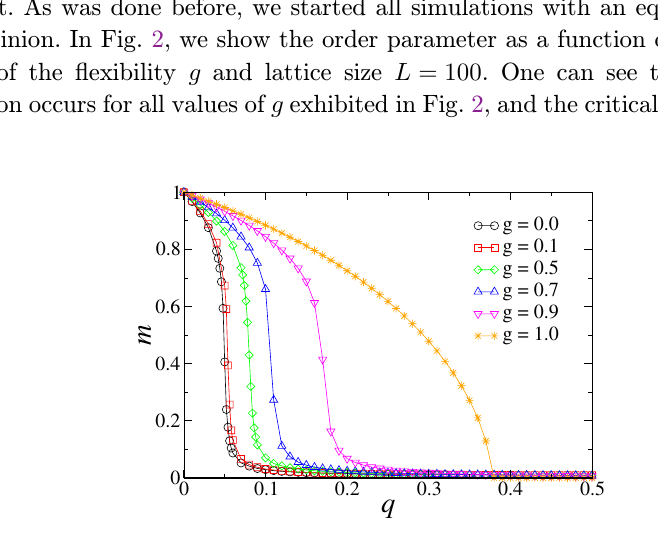
Fig. 2. Order parameter m as a function of q for the model on 2D square lattices for L ¼ 100 and typical values of g . One can see that the transition points depend on g . Results are averaged over 100